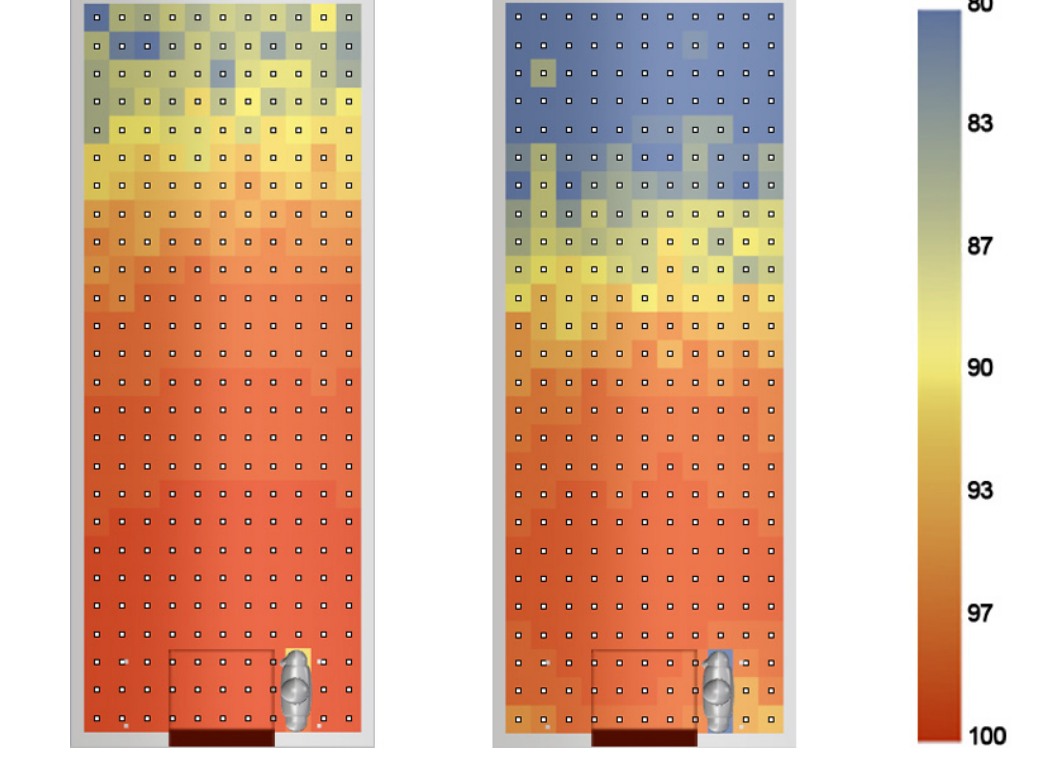
Table 4. Daylight Glare Index (DGI) scaling according to different